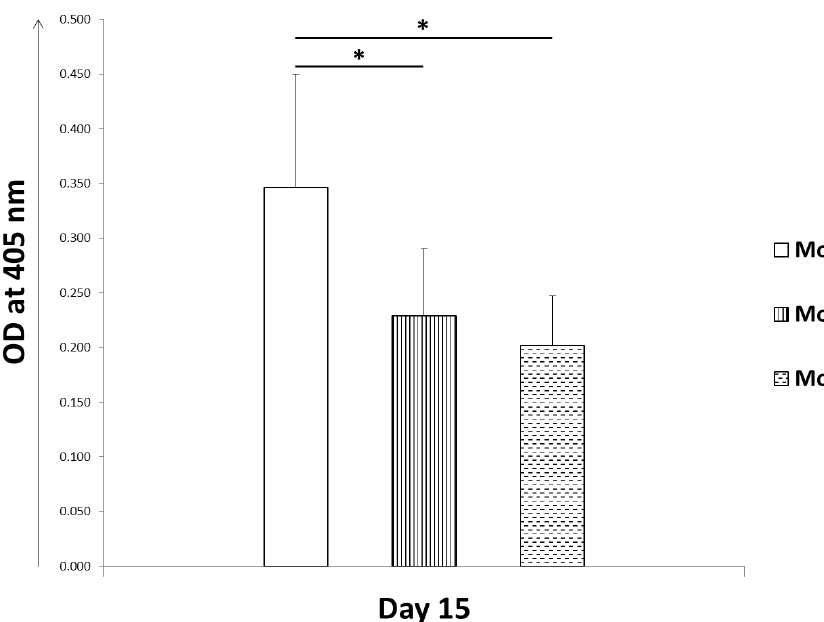
Figure 2. Human T cells inhibit osteoclast formation in vitro . Blood monocytes were di ff erentiated into osteoclasts in the presence of macrophage-colony-stimulating factor (M-CSF) and receptor activator of NF- κ B ligand (RANKL) for 15 days. T cells derived from human bone tissue, by cutting bones into fines pieces and separating cells by centrifugation, were separated into CD4 and CD8 T cells by flow cytometer. Addition of these isolated CD4 or CD8 T cells separately to the di ff erentiating blood monocytes led to a decrease in the number of osteoclasts being formed in vitro cellular coculture model when observed after 15 days post culture. A comparative method of colorimetric assay was used to determine the number of osteoclasts formed by measuring the TRAP activity through absorbance, which is a prominent osteoclast enzyme. The data is from three independent experiments. Student t tests were used to determine statistical significance (* p < 0.05).